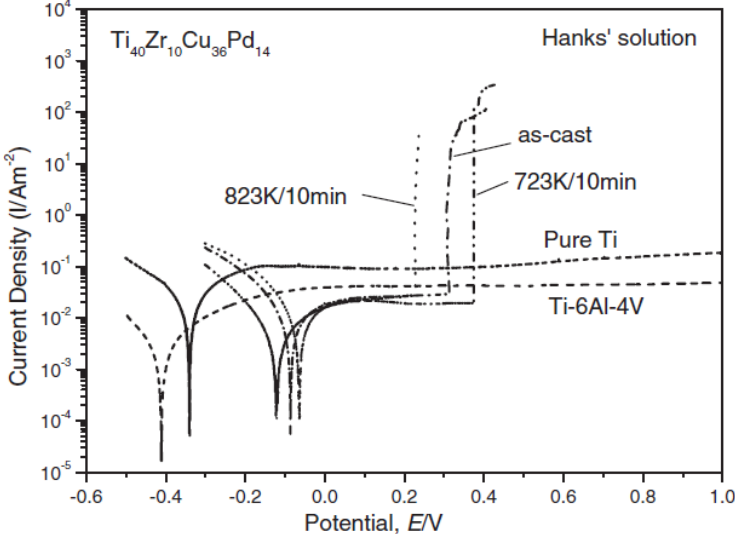
Figure 14. Anodic and cathodic polarization curves of the Ti 40 Zr 10 Cu 36 Pd 14 BMG and its crystalline alloys at 310 K in Hanks’ solution. Reproduced with permission from [221]. Copyright 2007, The Japan Institute of Metals and Materials.